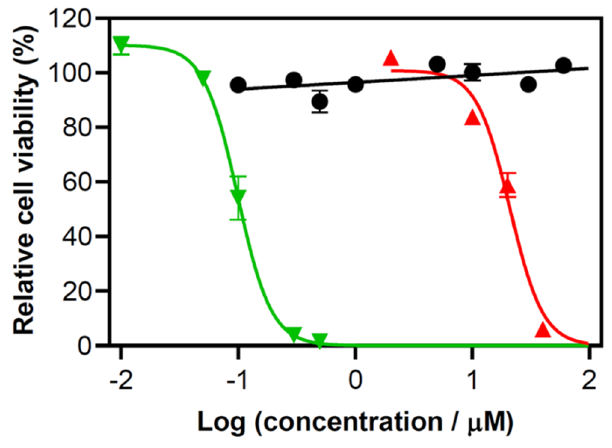
Figure 1. Relative cell viability of human lung adenocarcinoma (A549) cells treated with ruthenium-based photosensitizer (TLD1433). Cell viability was determined by resazurin assay. No exposure to light (black bold circles), irradiation at 532-nm light (green downwards triangle) at 28 mW / cm 2 for 20 J / cm 2 , and 630-nm light (red upwards triangles) at 65 mW / cm 2 for 230 J / cm 2 . Error bars represent standard error of the mean. Cells were treated with the following concentrations of TLD1433 before exposure to 532 nm light of 0.01, 0.05, 0.1, 0.3 and 0.5 µ M. Similarly, cells were treated with TLD1433 concentrations of 2, 10, 20, and 40 µ M before 630 nm light illumination. TLD1433 only (no exposure to light) was assessed at higher concentrations of TLD1433: 0.1, 0.3, 0.5, 1, 5, 10, 30, and 60 µ M. In vitro experiments were completed in triplicate.